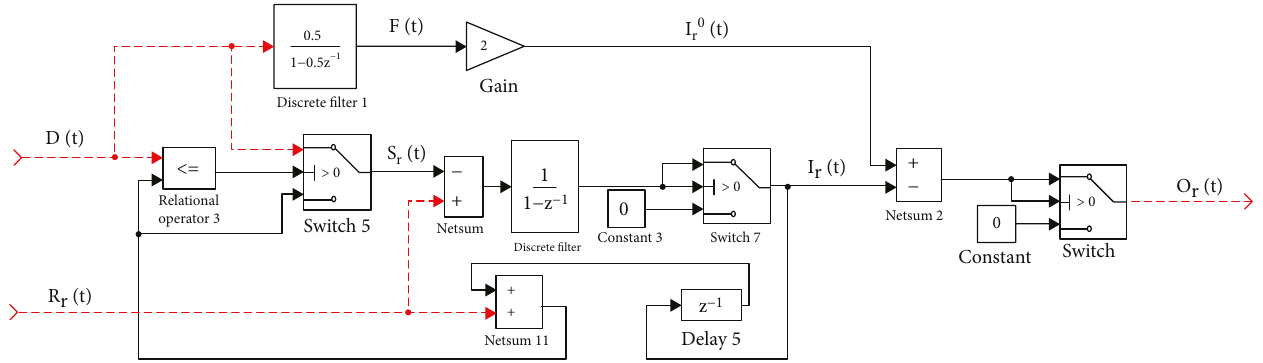
Figure 2: The block diagram of the inventory system of the